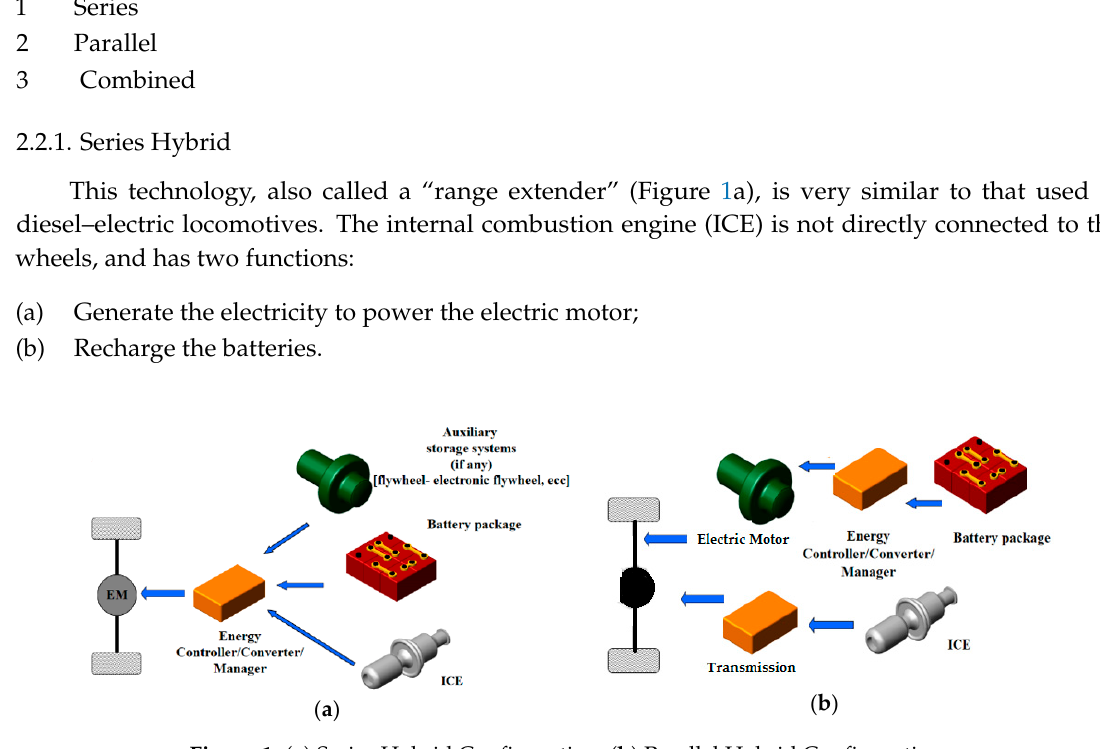
Table 3. Series Hybrid Specifications [4,5].